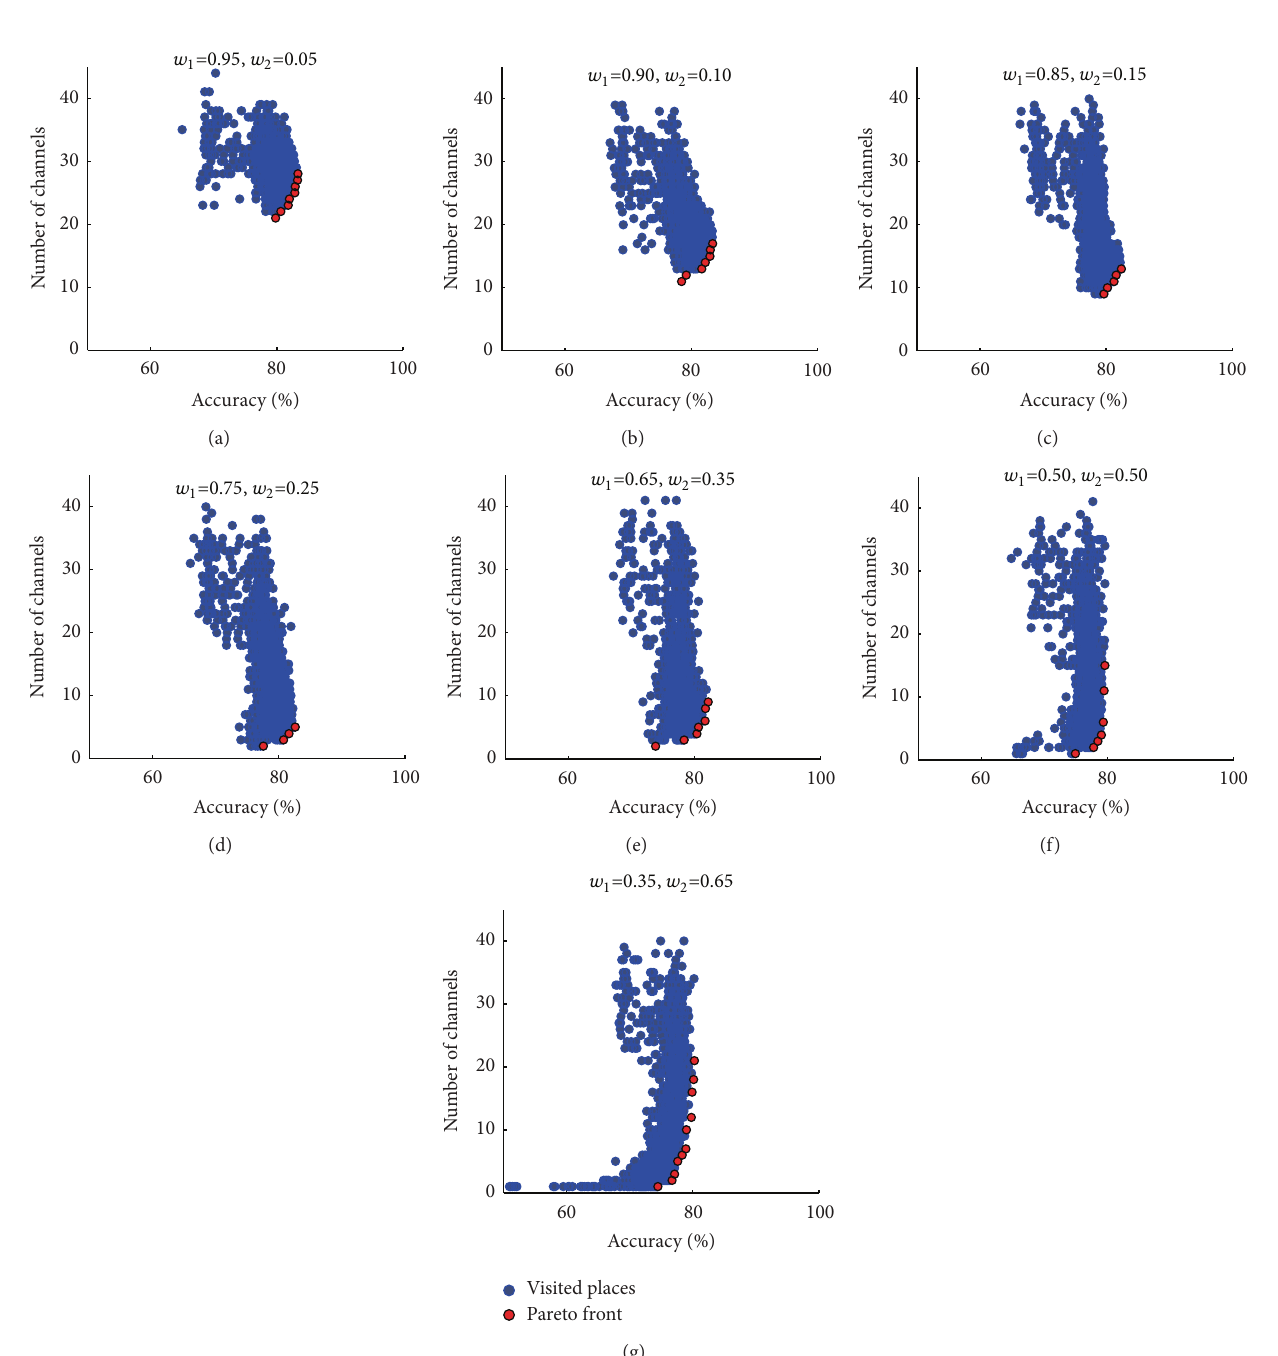
Figure 6: Illustration of the Pareto front found by the algorithm in each MHPSO case for a representative subject. The vertical and horizontal axes denote the number of selected channels and the average classification accuracy, respectively. The blue dots show the fitness of all the positions visited by the swarm. The red dots represent are the positions that belong to the Pareto front. The first MHPSO case was omitted because the Pareto front in this case is